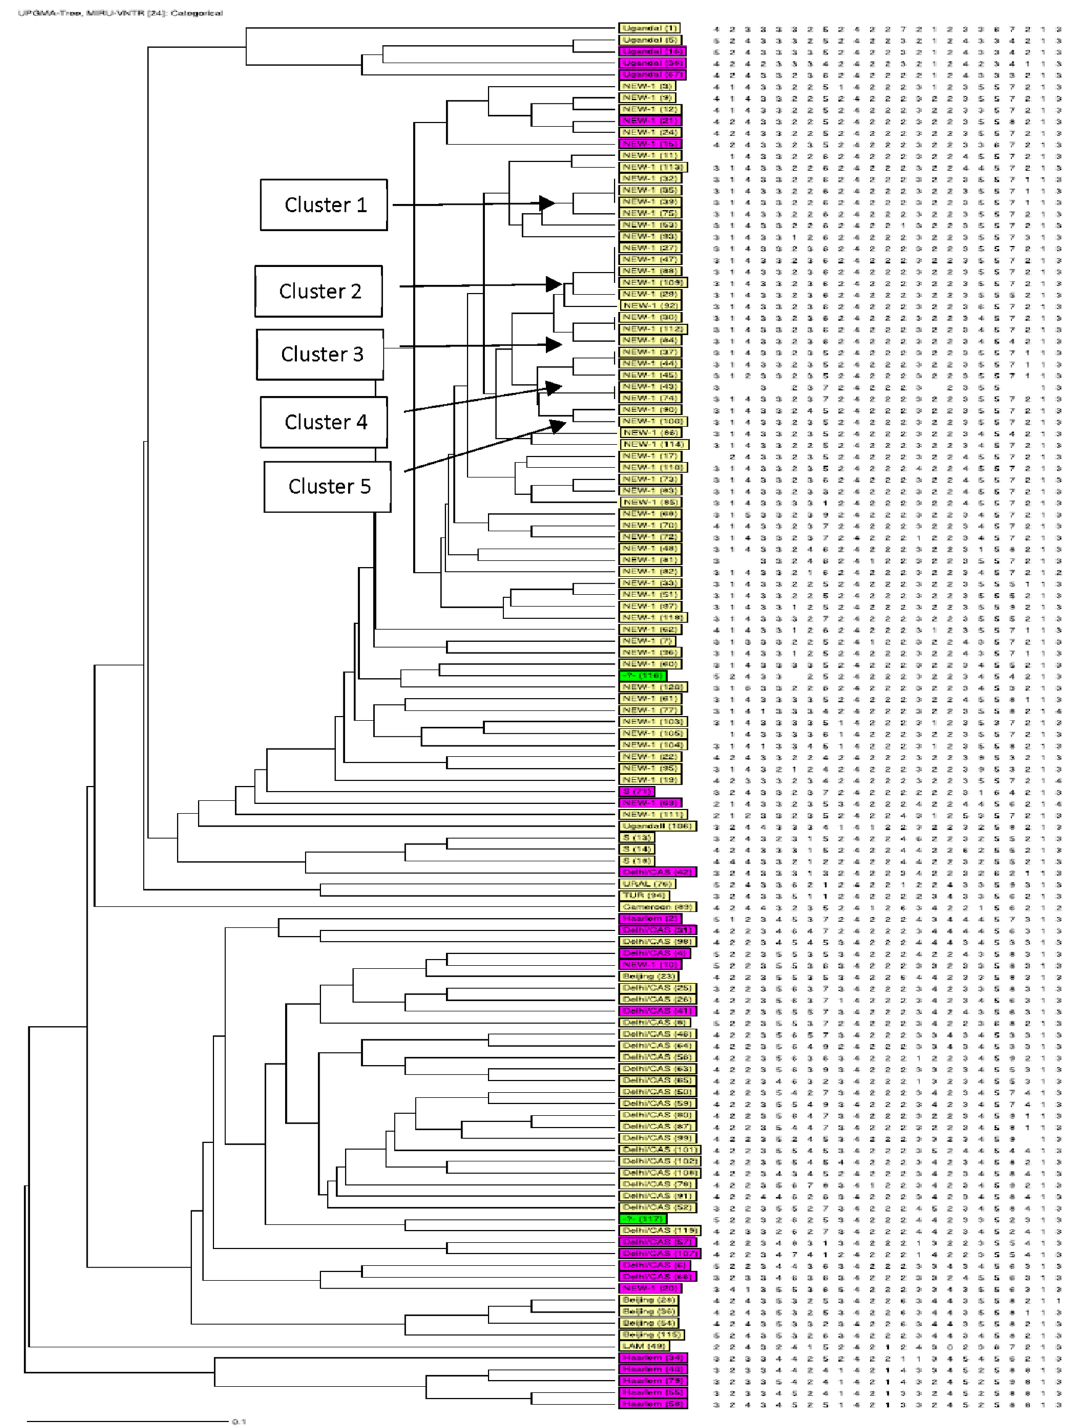
Figure 1. UPGMA tree showing genetic relatedness of 120 isolates from Khorasan Razavi province based on the 24-locus MIRU-VNTR. Genotype and copy numbers are mentioned for each isolate along with the dendrogram, except for isolate with polyclonal infection. The arrangement of MIRU-VNTR loci from left to right including: MIRU 02, Mtub04, ETR C, MIRU 04, MIRU 40, MIRU 10, MIRU 16, Mtub21, MIRU 20, QUB- 11b, ETR A, Mtub29, Mtub30, ETR B, MIRU 23, MIRU 24, MIRU 26, MIRU 27, Mtub34, MIRU 31, Mtub39, QUB-26, QUB-4156, MIRU 39. Yellow color genotypes were identified by MIRU-VNTR plus, Violent color genotypes were identified by TB miner and green color genotypes were